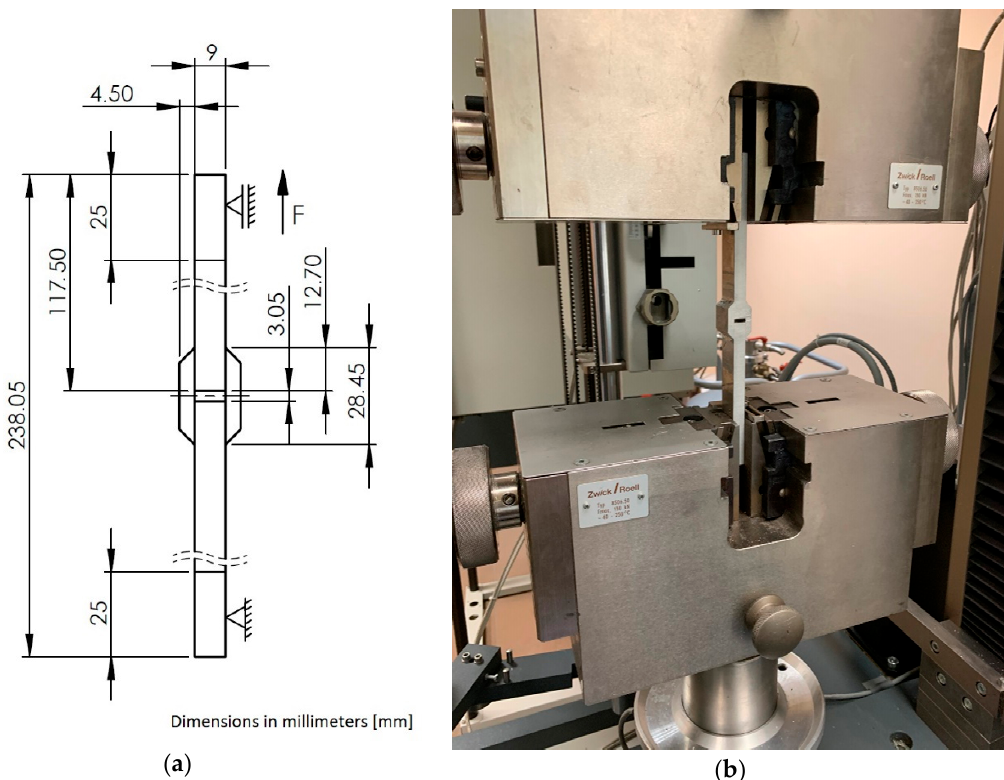
Figure 2. The drawing of a 25.4 mm wide double-lap sample with the main dimensions ( a ). An example of a sample compliant with ASTM 3528 in the test rig of a Zwick Roell Z150 testing machine ( b ).